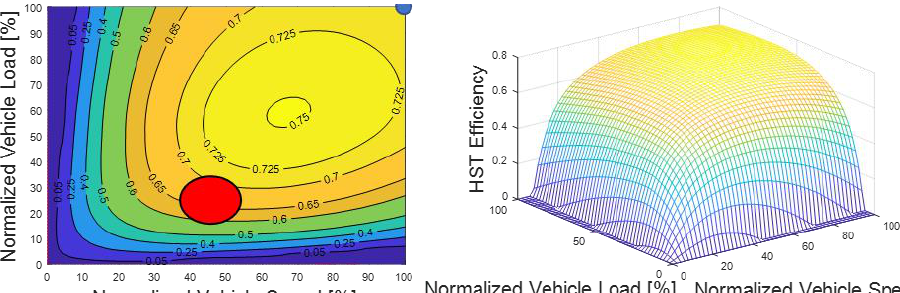
Figure 15. HT System Efficiency Map Data ( Left ) and HT System Efficiency Map ( Right ). Representative Working Condition